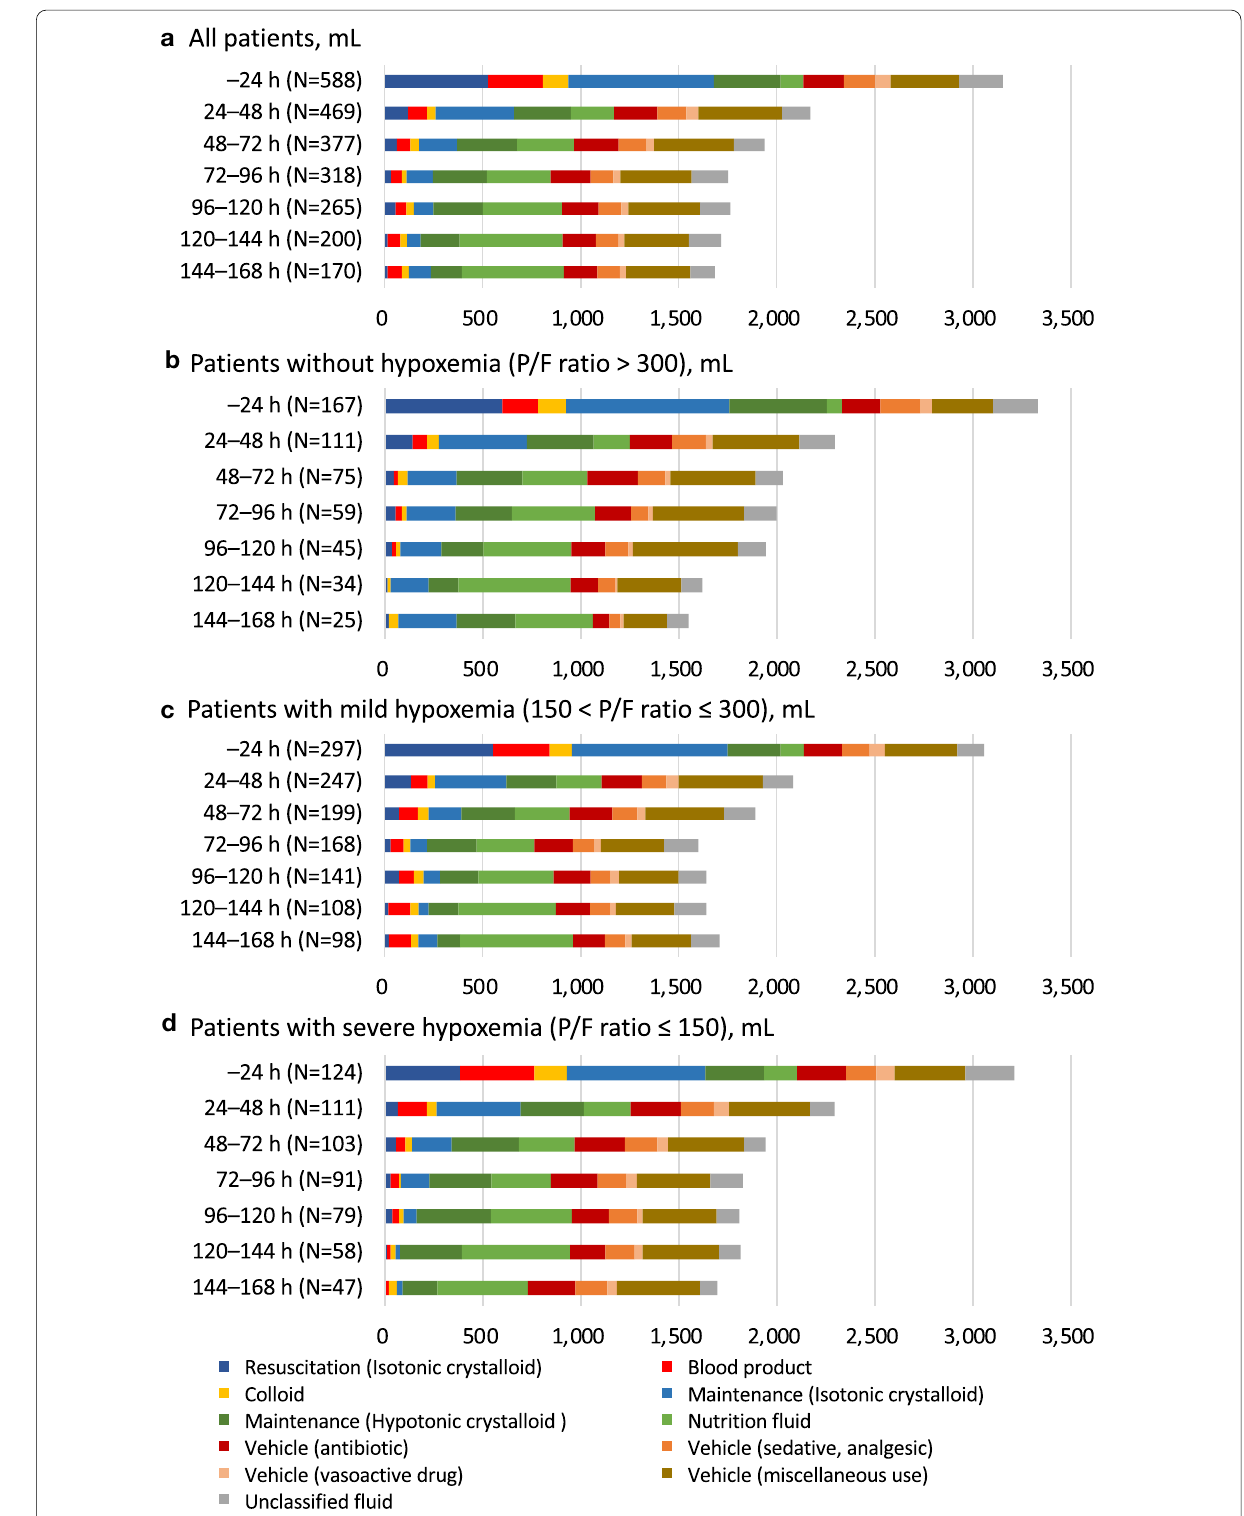
Fig. 2 Daily intravenous fluids intake. a All patients; b patients without hypoxemia (P/F ratio > 300); c patients with mild hypoxemia (150 < P/F ratio 300); d patients with severe hypoxemia (P/F ratio 150). The dosage of the liquid drug was defined as an unclassified fluid. Abbreviations: ≤ ≤ P/F ratio, ratio of arterial oxygen partial pressure to fractional inspired